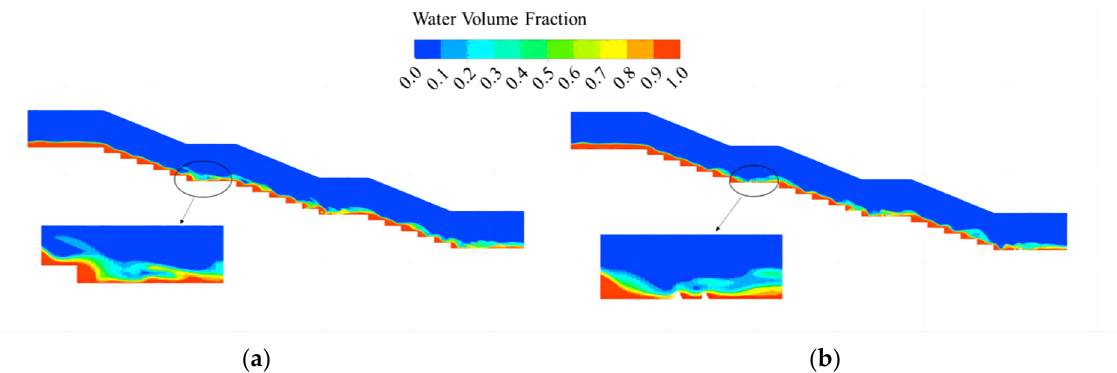
Figure 8. Flow pattern of different longitudinal sections in a double row arrangement. ( a ) y = 5 cm, and ( b ) y = 7 cm.